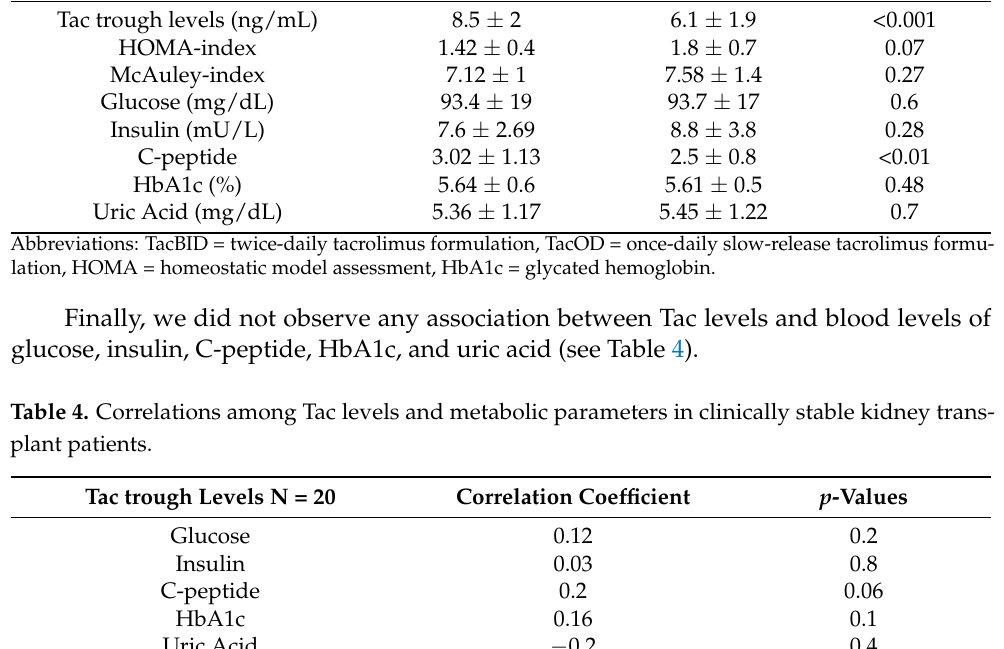
Table 3. Tac through levels. insulin resistance indexes and metabolic parameters before and after the switch from TacBID to TacOD. N = 20 TacBID TacOD p -Values Tac trough levels (ng/mL)